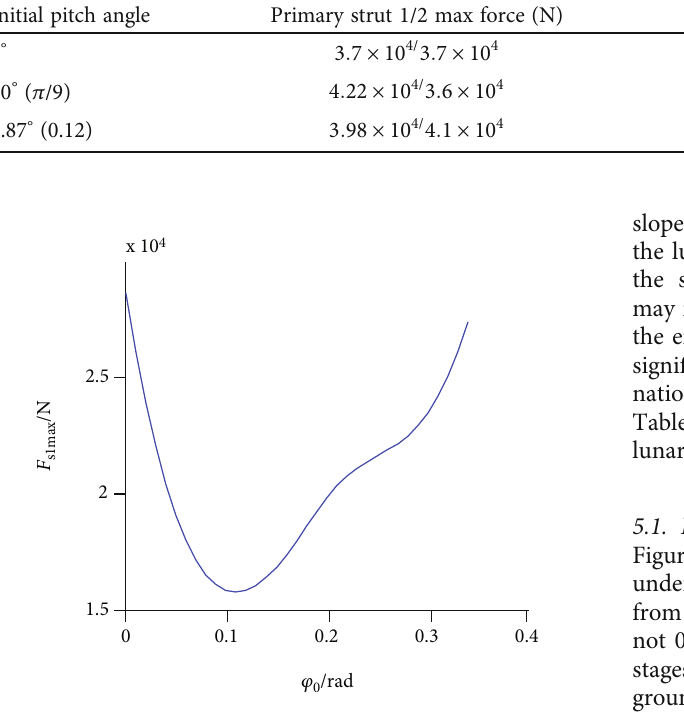
Figure 16: Max force on the secondary strut 1 vs. initial pitch angle.